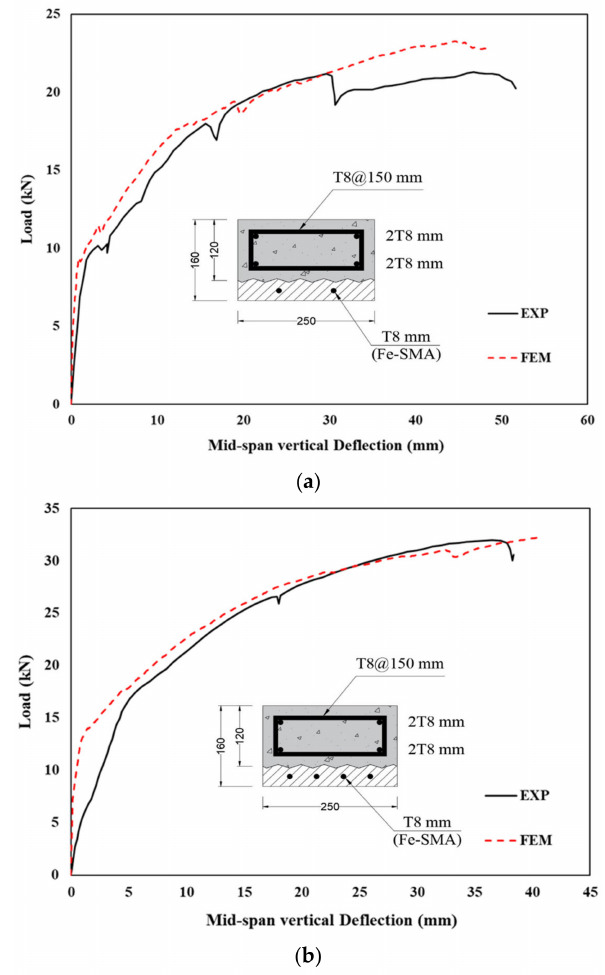
Figure 11. Load-deflection response for beams 10 and 11 [31]: ( a ) beam 10, ( b ) beam